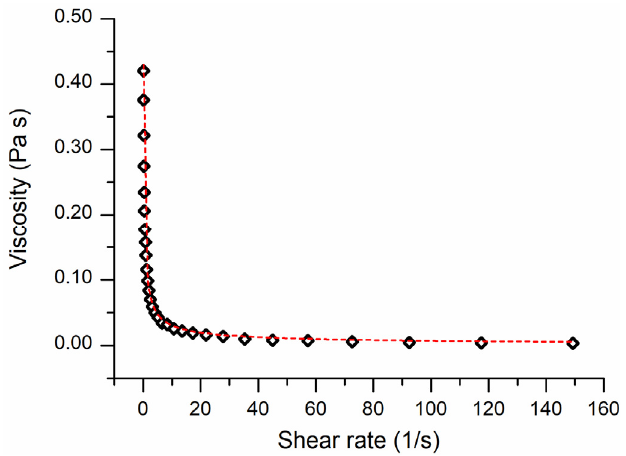
Figure 5. Apparent viscosity variation of the FEO-NC suspension as a function of shear rate. The red dashed line was obtained by fitting the viscosity variation using power law model.